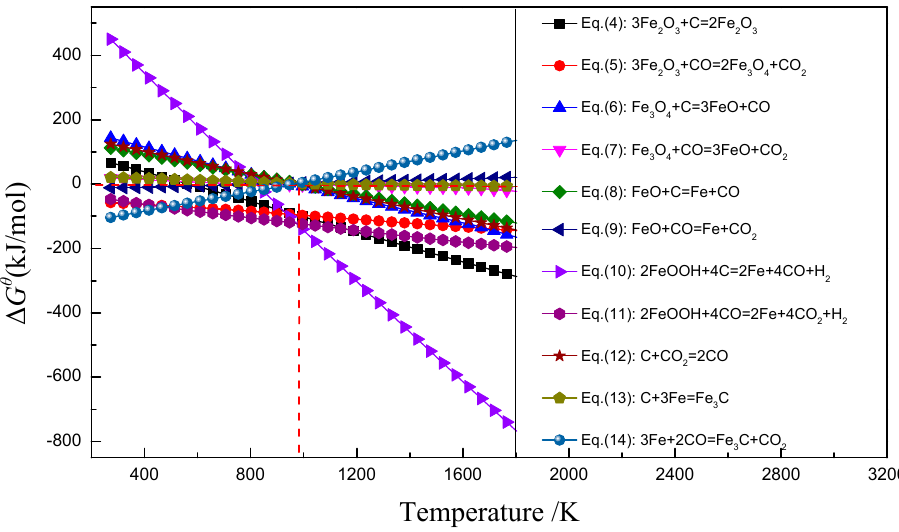
Figure 4. The standard free energy ( Δ G θ ) with temperatures for Equations (4)–(14).